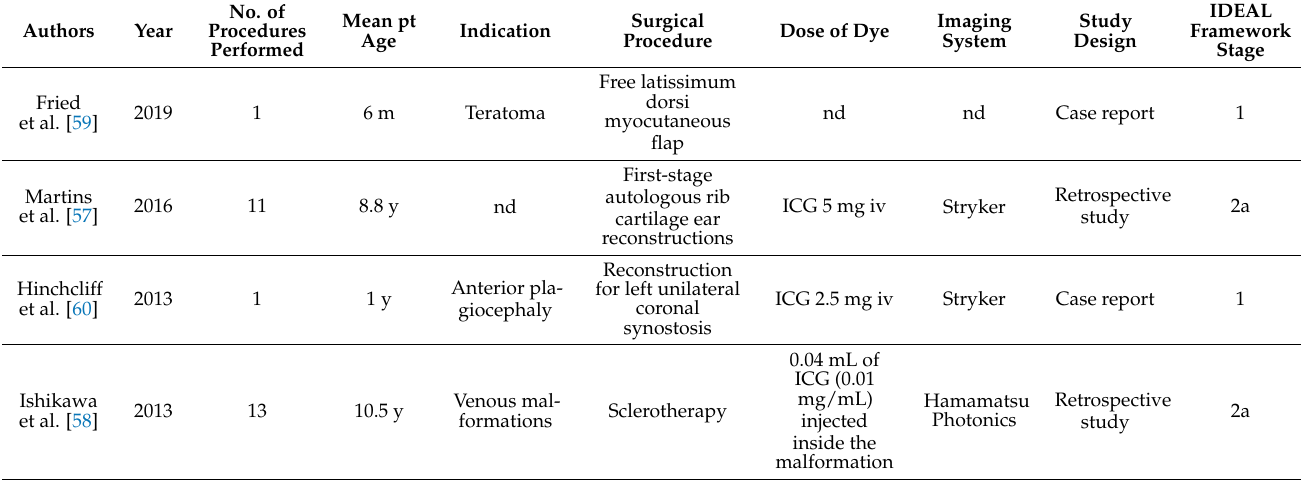
Table 6. Summary for plastic surgery.